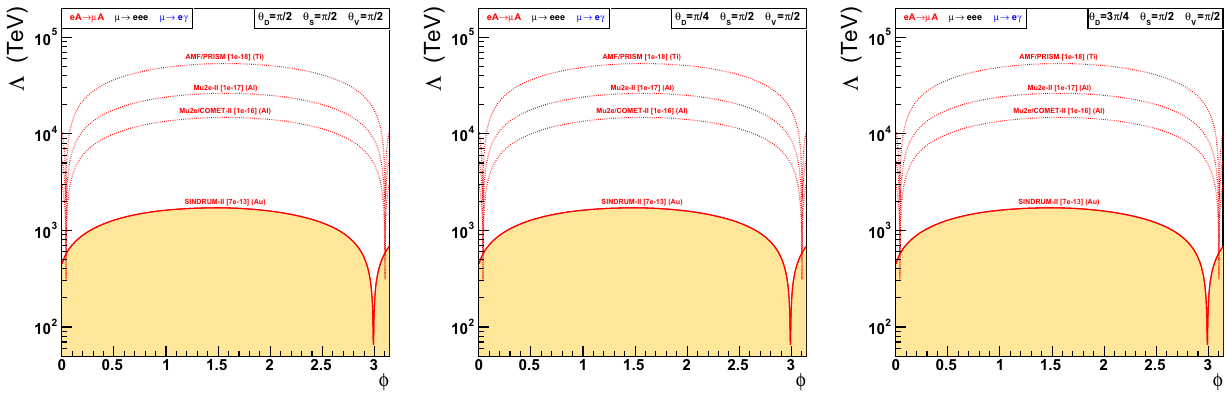
0 → π ; the rates for φ ∈ (π → 2 π) with positive dipole are equal to those with negative dipole and φ ∈ ( 0 → π) . The solid region is currently